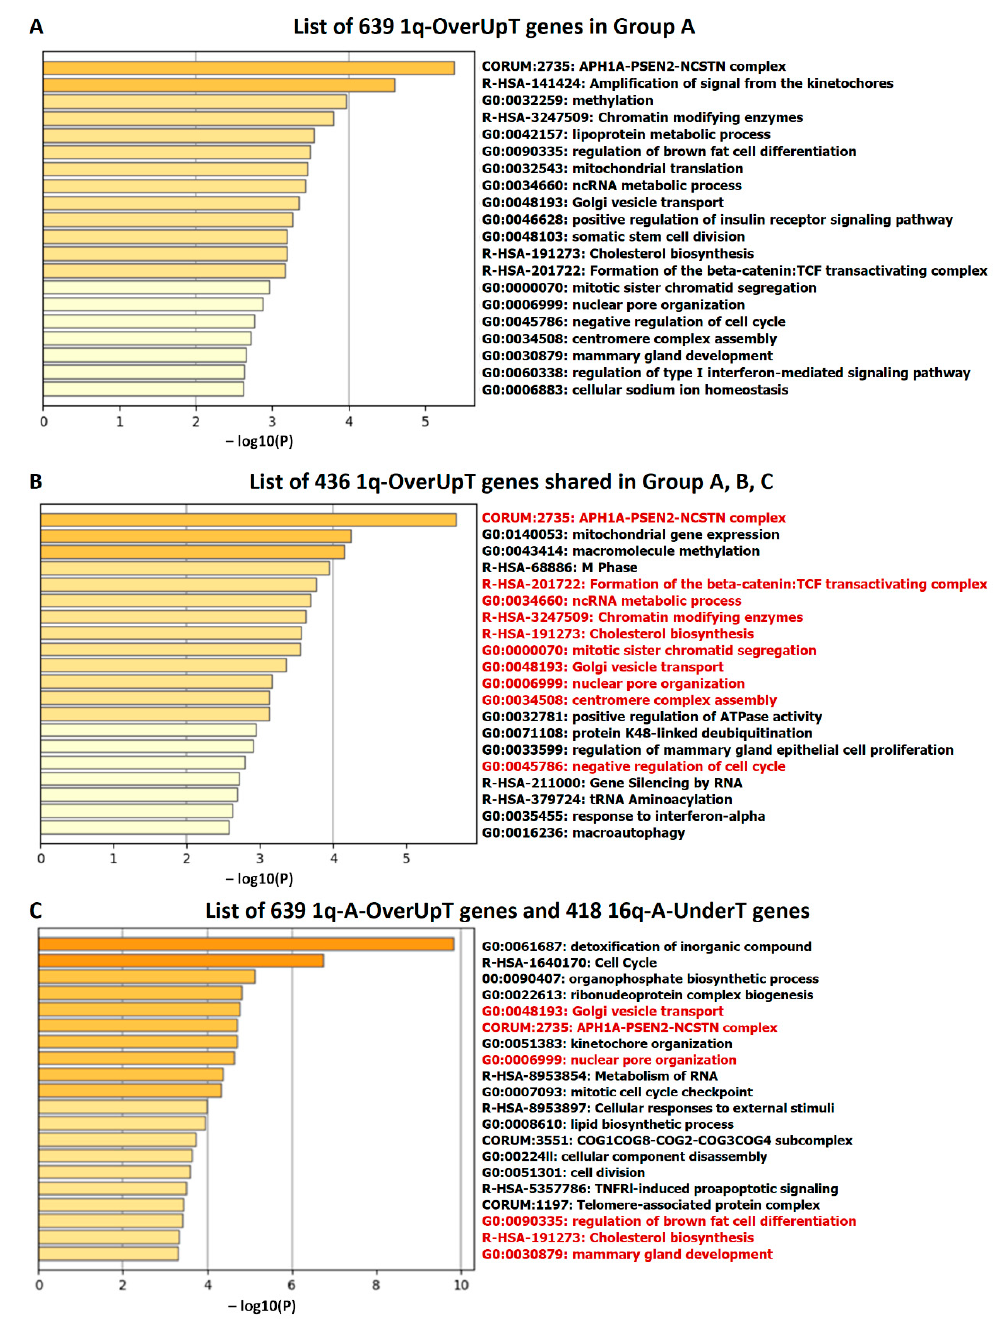
Figure 8. Pathway enrichment analysis using: ( A ) the list of 639 1q-OverUpT genes in group A, ( B ) the list of 436 1q-OverUpT genes shared among the three 1q-gain groups, and ( C ) the combined list of 639 1q-A-OverUpT genes (FCvsCTRL > 1.3 at adjp < 0.05 and FCvsN >1 at adjp < 0.05) and 418 16q-A-UnderT genes. Pathways in red letters in ( B , C ) are present also in ( A ).